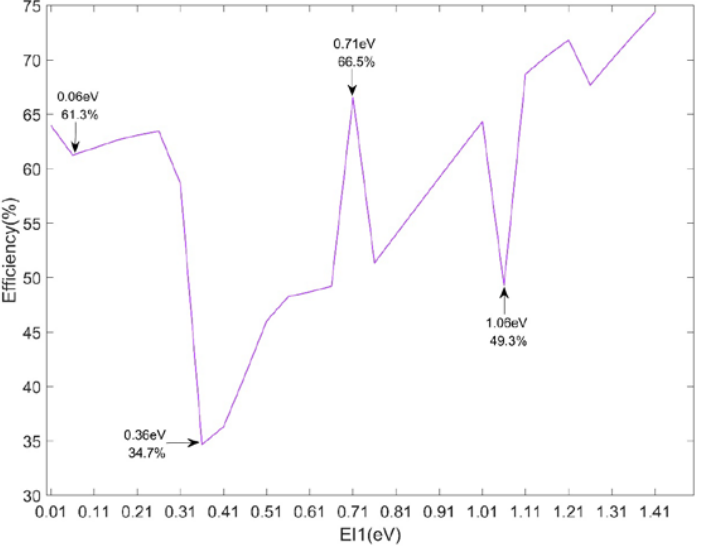
Figure 5. Efficiency for E I 2 = 1.06 eV, where E I 1 changes from 0.01 eV to 1.41 eV.